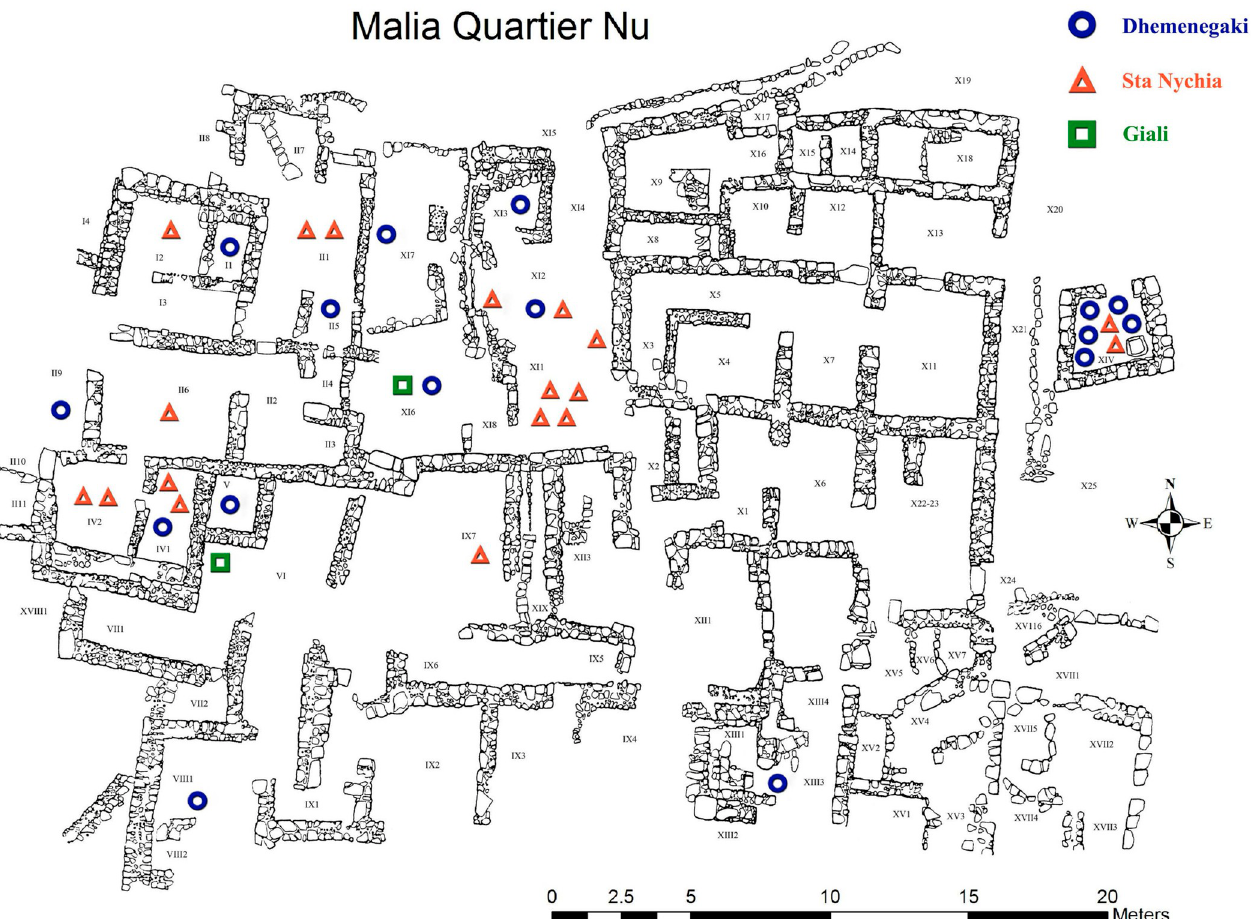
Fig 4. Plan of Quartier Nu indicating distribution and source of artifacts characterized. Plan reproduced with permission of the E´cole Franc¸aise d’Ath è nes, with additions by Kress, N, Mili ć , M.